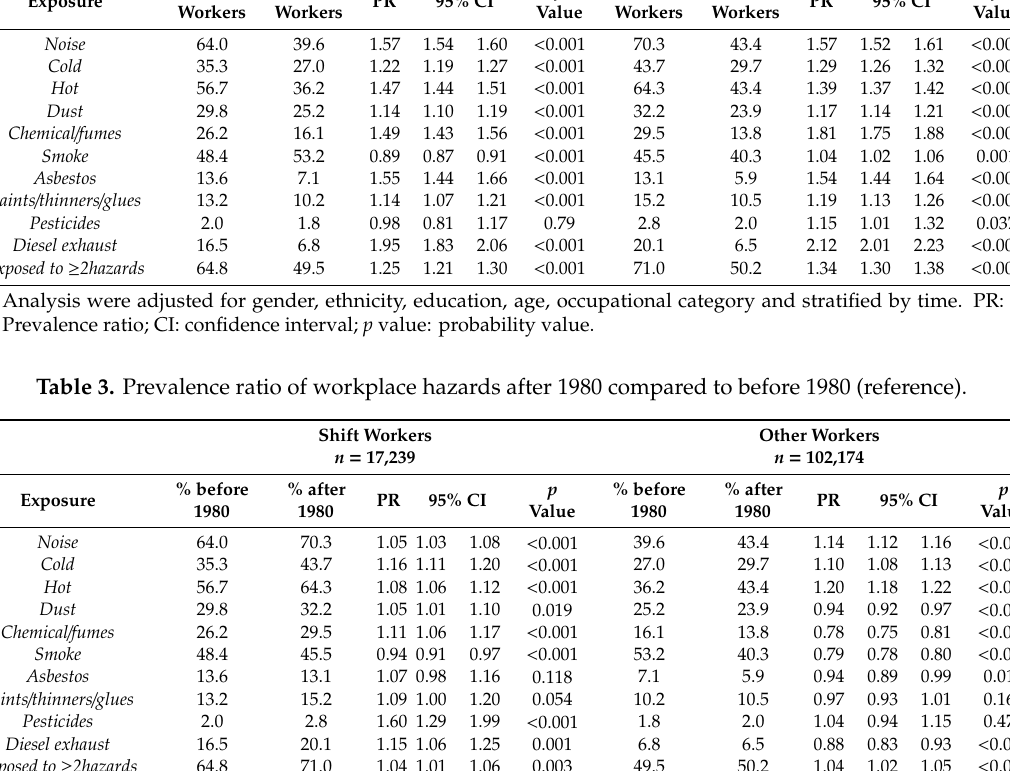
Table 2. Prevalenceratioofworkplacehazardsamongshiftworkerscomparedtootherworkers(reference). Job Ended Before 1980 n = 59,692 Exposure